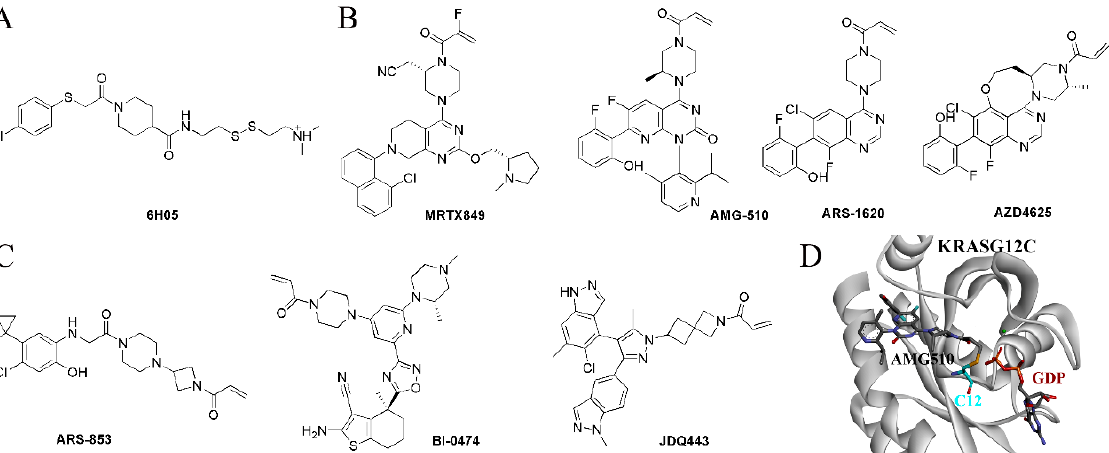
Figure 2. The KRAS-G12C-specific inhibitors. ( A ) The structure of 6H05. ( B ) The quinazoline ring- based inhibitors. ( C ) The inhibitors with other core structures. ( D ) The covalent bond between AMG-510 and C12.